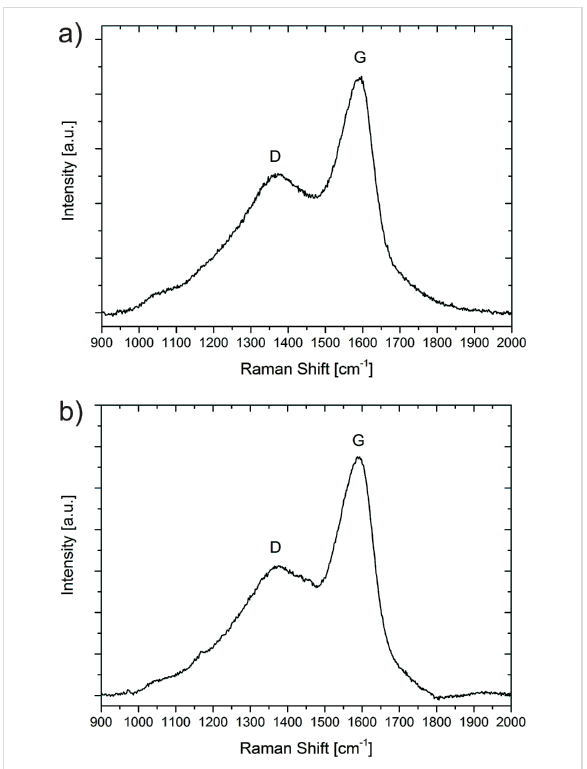
Figure 2: Raman spectra in the 900–2000 cm − 1 range, for low- and high-density carbon